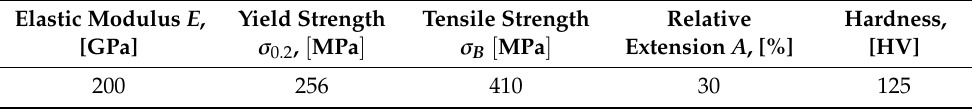
Table 2. Mechanical properties of samples from steel